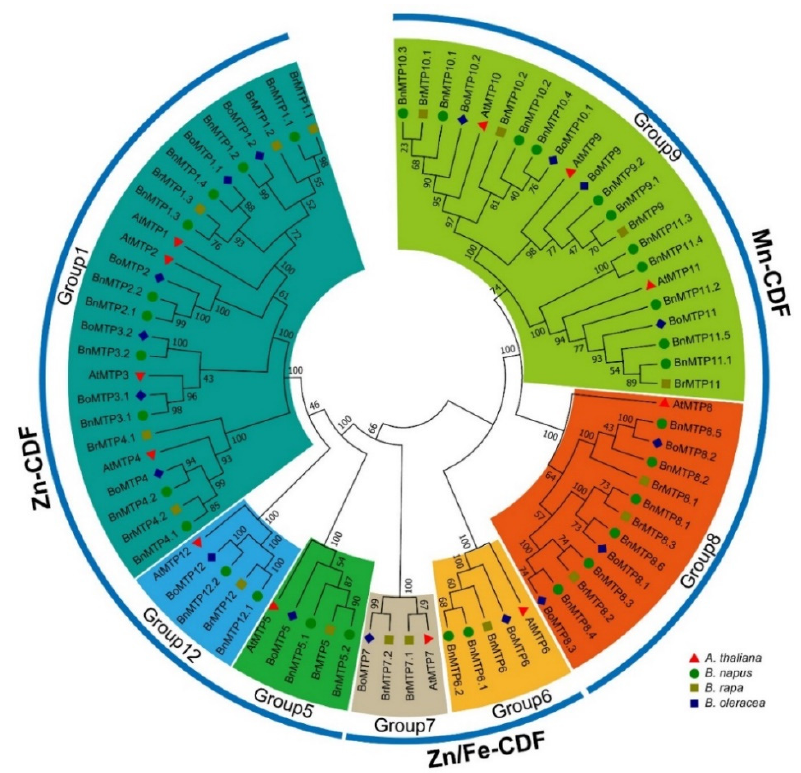
Figure 1. Phylogenetic relationships of MTP proteins in A. thaliana , B. rapa , B. oleracea , and B. napus using MEGA 6.0 with the neighbor-joining (NJ) method. The numbers at the nodes represent the reliability percentage of the bootstrap values based on 1000 replications. The red triangle, green circle, brown square, and blue diamond represent MTPs from A. thaliana , B. rapa , B. oleracea , and B. napus, respectively.